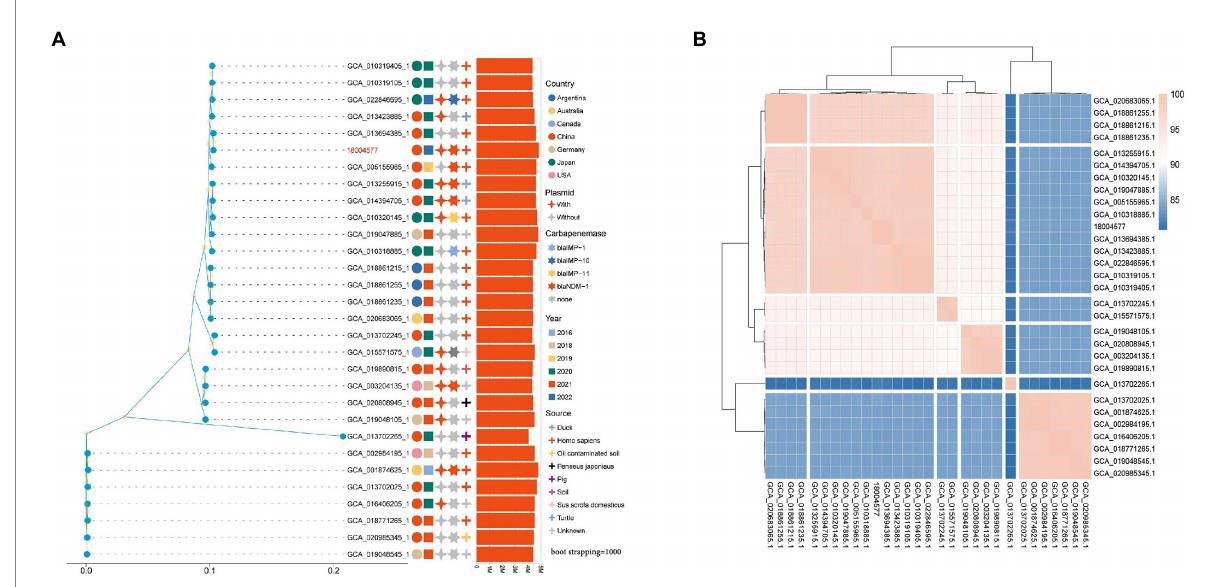
FIGURE 7 (A) Phylogenetic tree of the Providencia rettgeri strains. Isolation source, year, and geographical provenience of each strain are reported. The number of plasmids and types of carbapenemase genes were marked with different colors and shapes on the right side of the tree; (B) Correlation matrix of average nucleotide identity for the 30 P . rettgeri genomes obtained by